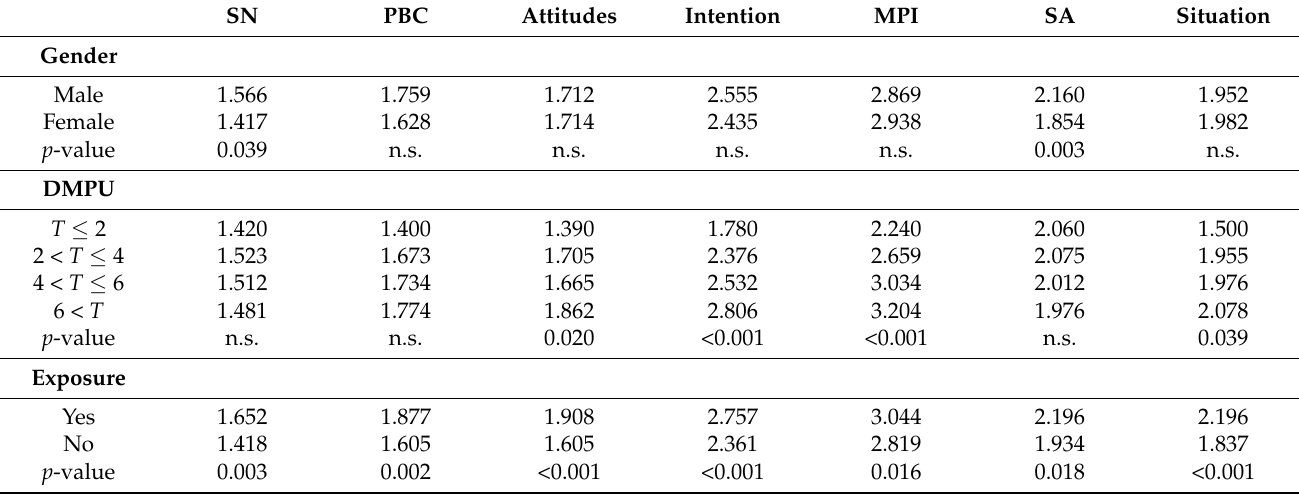
Table 4. Differences in constructs (mean) between participants grouped by demographic